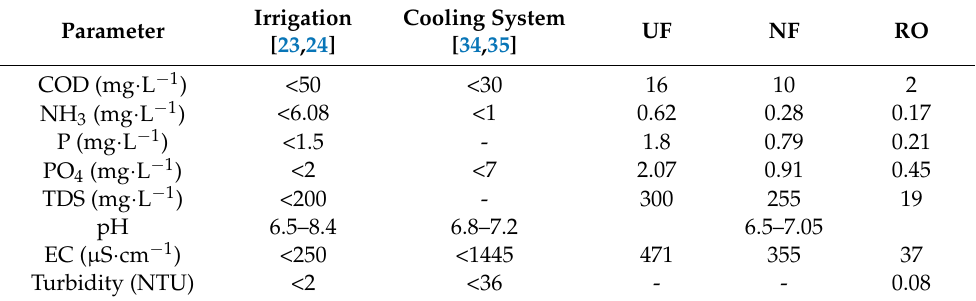
Table 5. Characteristics of UF/NF/RO effluent average water quality with reuse criteria for wastew- ater in different